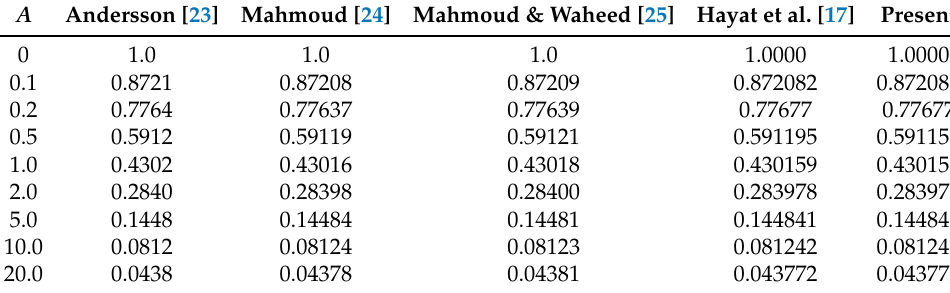
( 0 ) for various values of A when γ = M = 0. 1